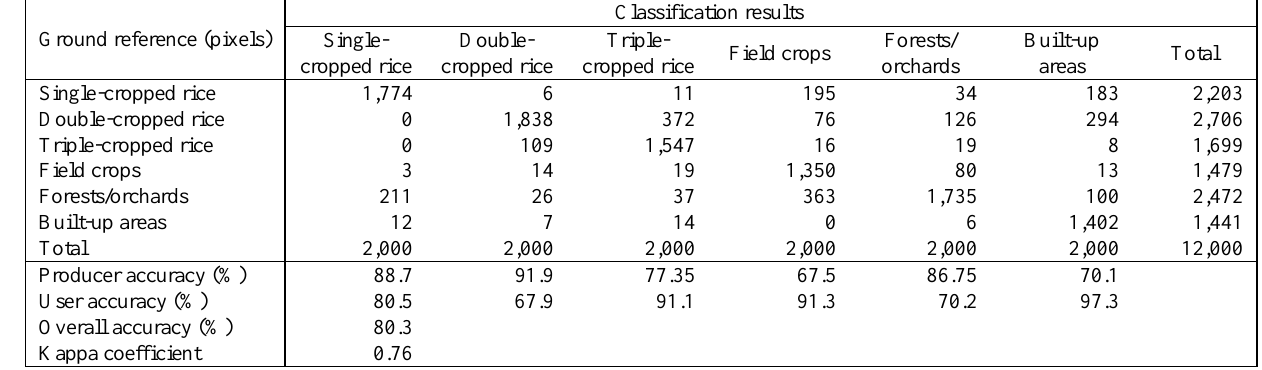
Table 1. Results of the classification accuracy